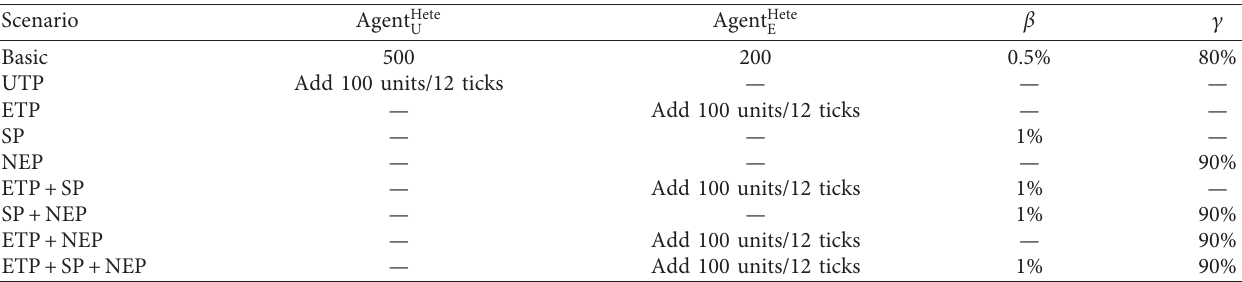
Figure 5: Netlogo 6.0.4 simulation Table 4: Parameters’ design for eight scenarios.